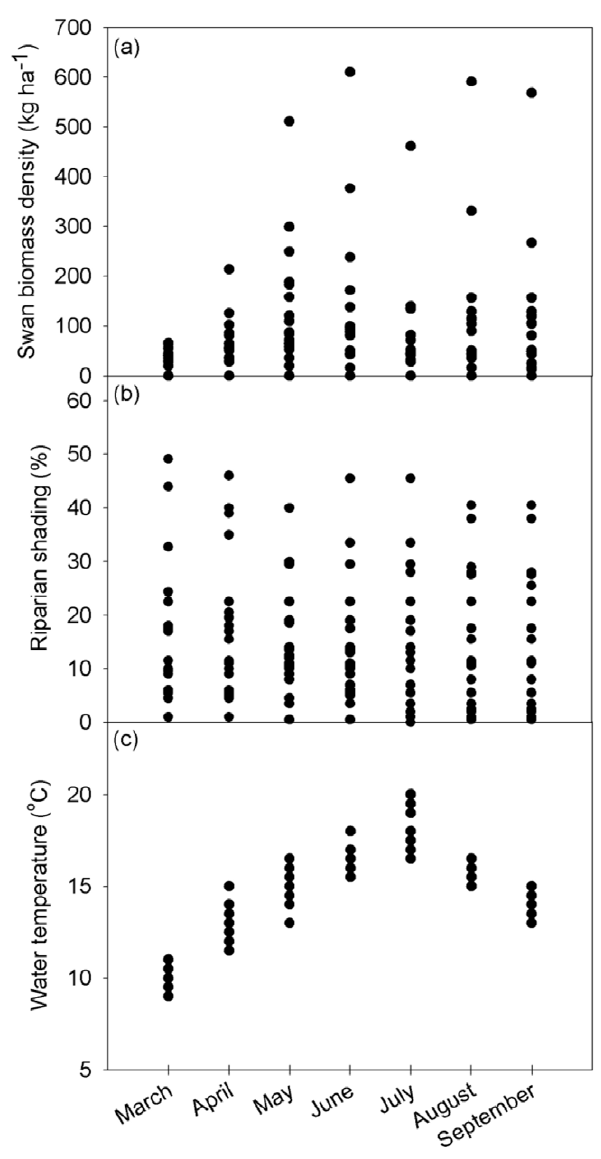
Figure 2. Observed spatiotemporal variance in (a) swan biomass density, (b) riparian shading, (c) water temperature at the 20 sites.